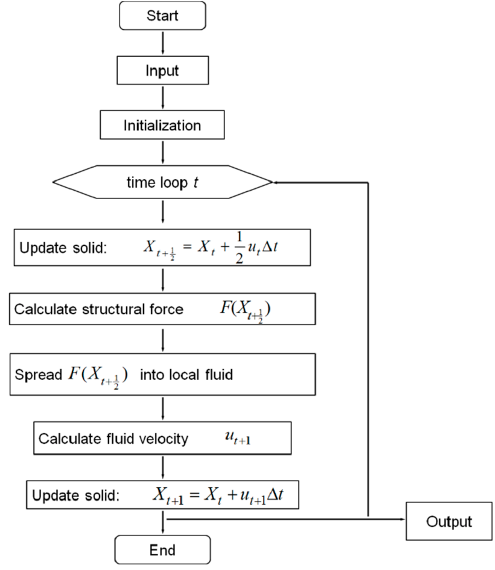
Figure 2. The algorithm flow chart of immersed boundary method.